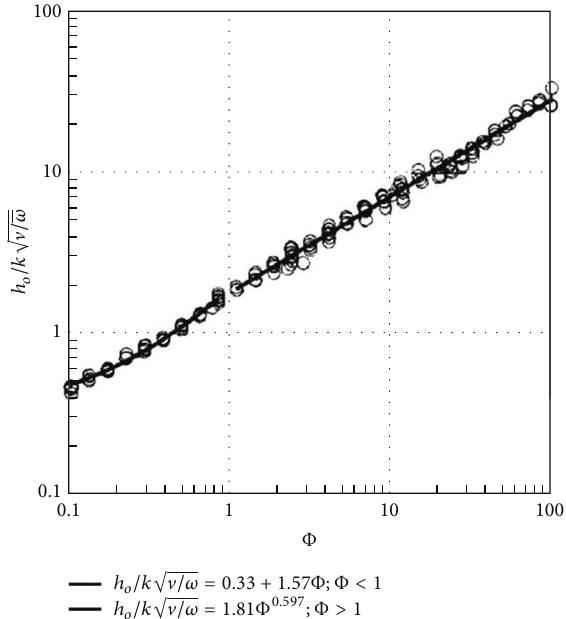
Figure 7: Convective heat transfer coefficient at the flow stagnation point of a jet perpendicularly impinging on the centre of a rotating disk. Adapted from Astarita and Cardone